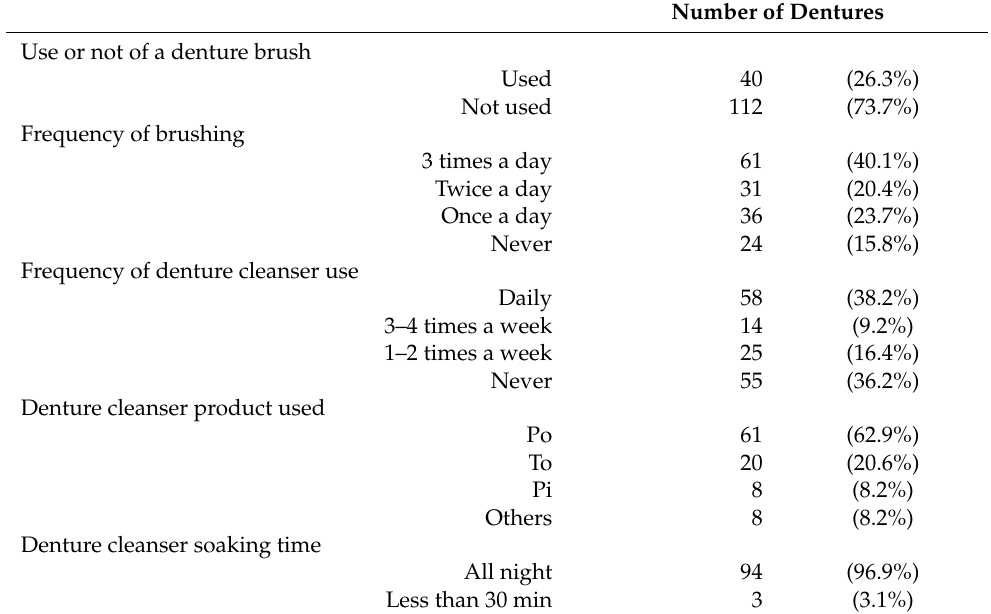
Table 1. Denture cleaning